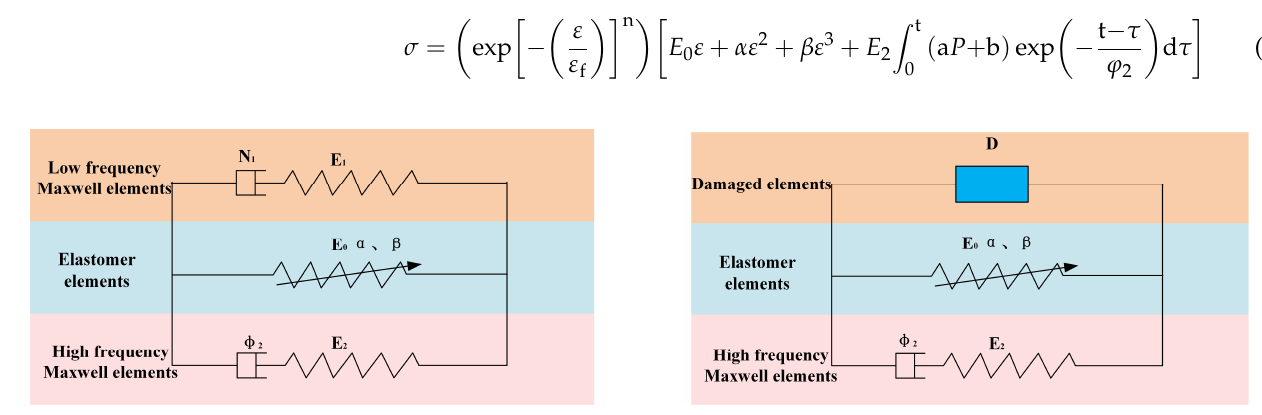
Figure 15. Constitutive model.